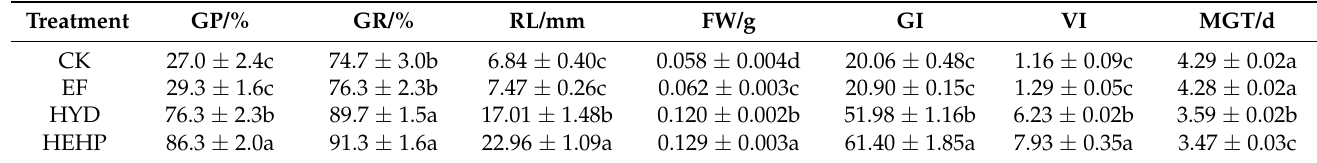
Table 1. Effects of different treatments on carrot seed germination characteristics.